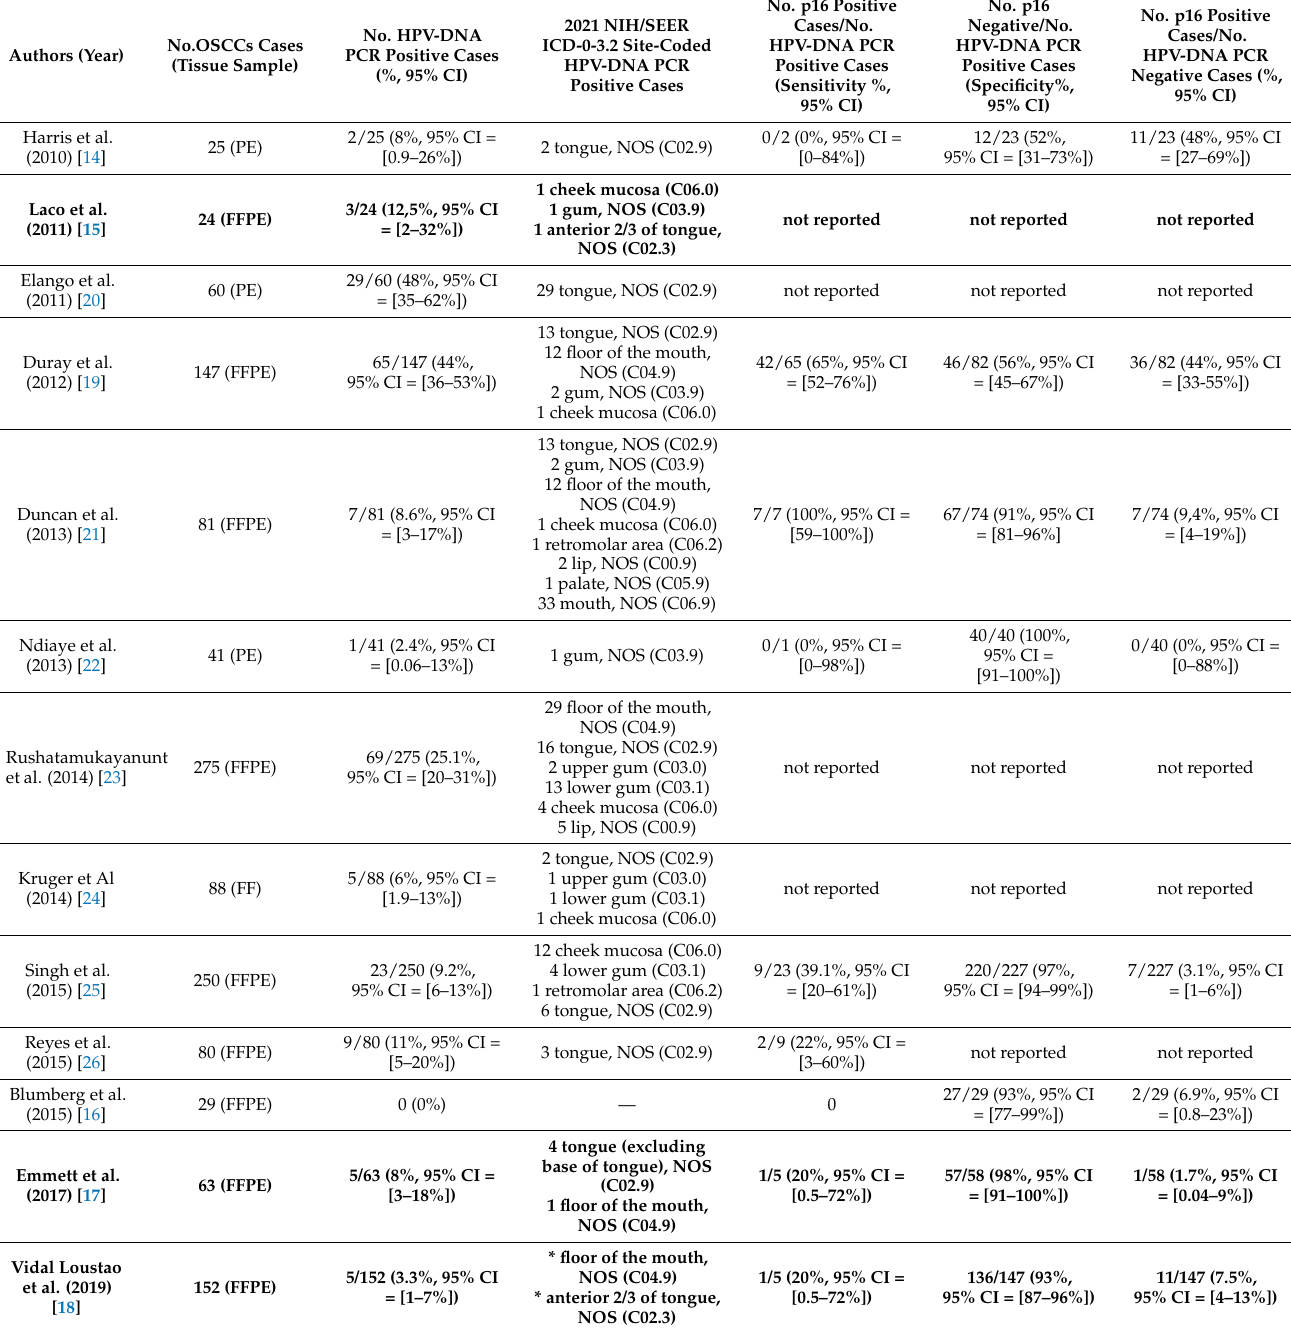
Table 4. Summary of HPV frequency studies from 2010 to 2020, using PCR and p16 as viral identification techniques and re-coding by the 2021 NIH/SEER ICD-0-3.2 classification of OSCC sites. In bold are the three studies that reported a distinction between the ‘anterior 2/3 of tongue/C02.3’ and the generic ‘tongue, NOS (C02.9)’, with the following HPV frequency